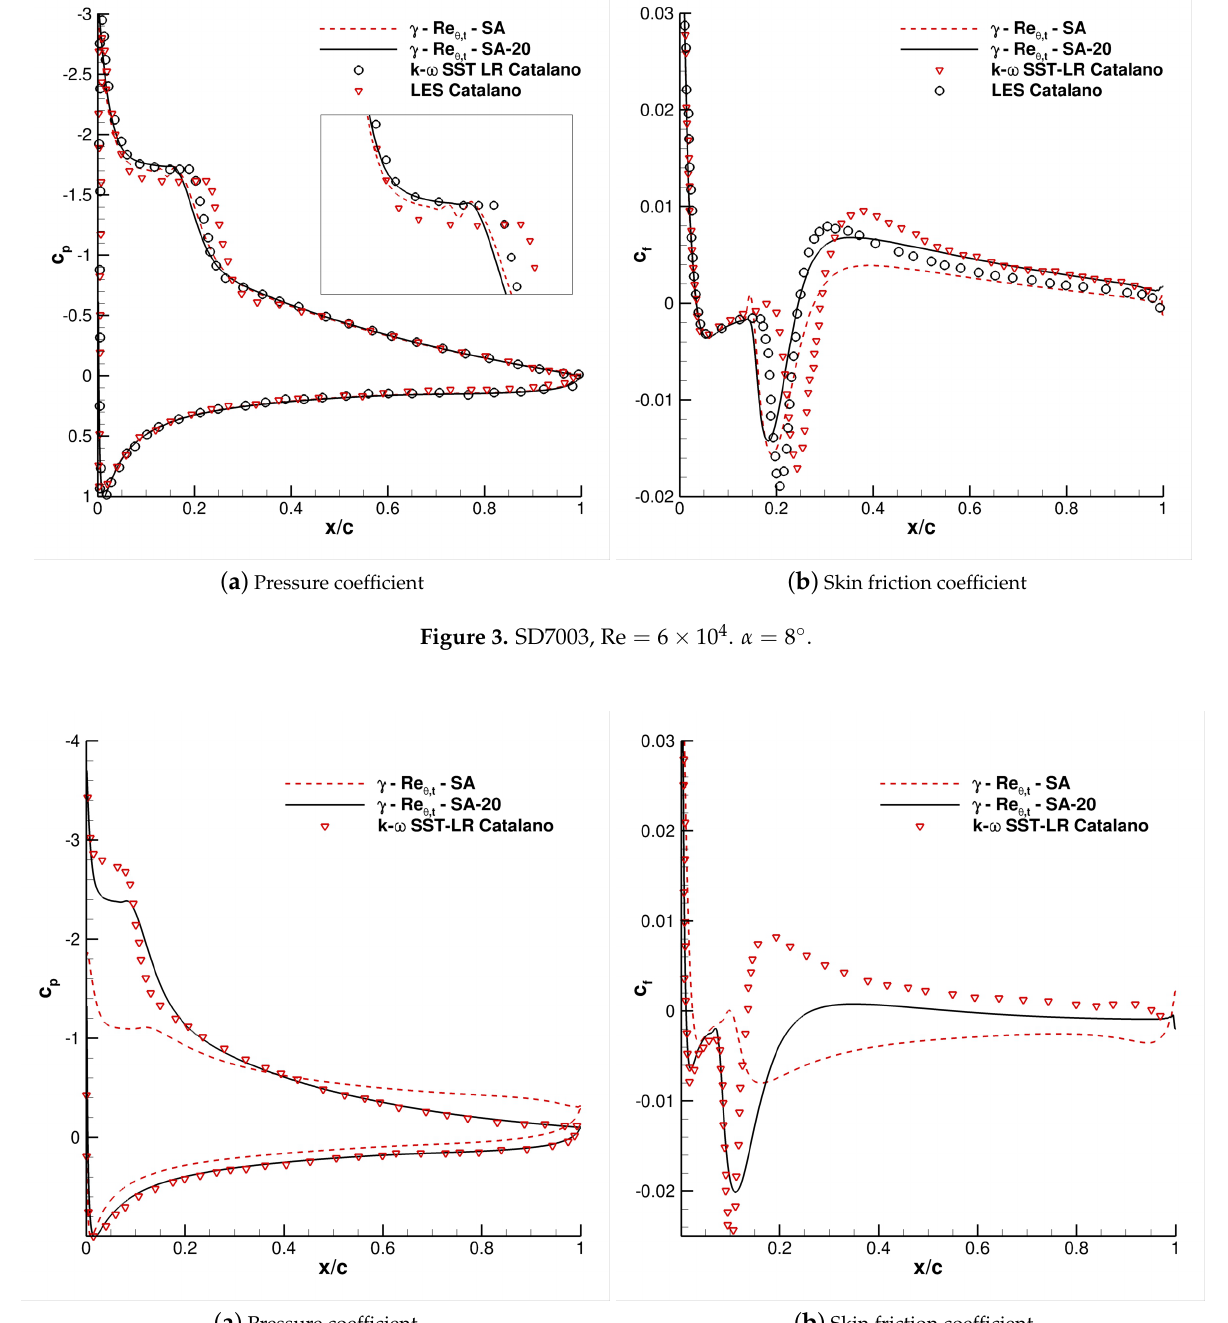
Figure 4. SD7003, Re = 6 × 10 4 . α = 10 ◦